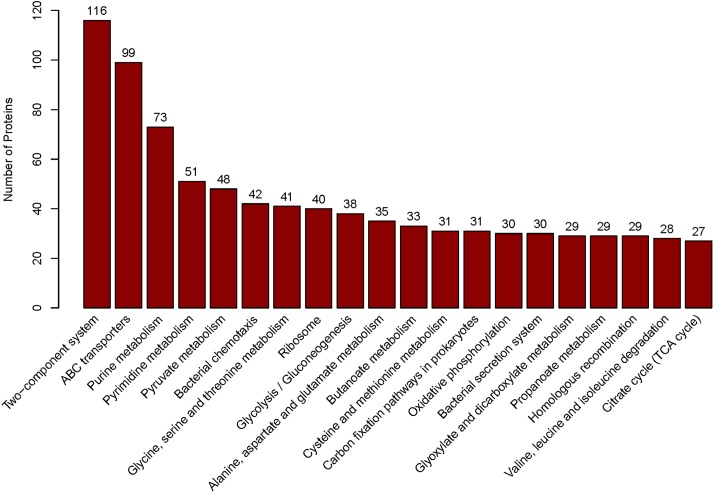
The top 20 pathways. Those pathways were sorted by the protein numbers which annotated the corresponding pathway. Therefore, more annotated proteins involved in the pathway, the higher bar is.